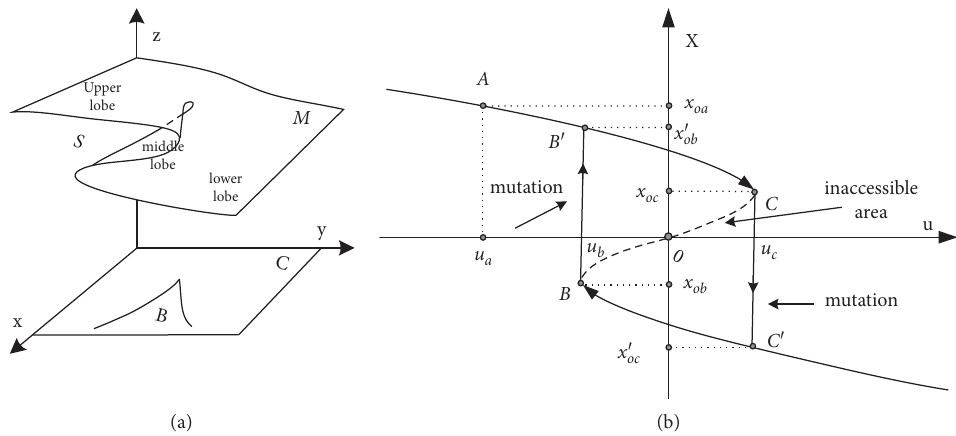
Figure 1: Diagram of cusp catastrophe model. (a) Cusp catastrophe equilibrium surface. (b) Schematic diagram of cusp mutation streamline.